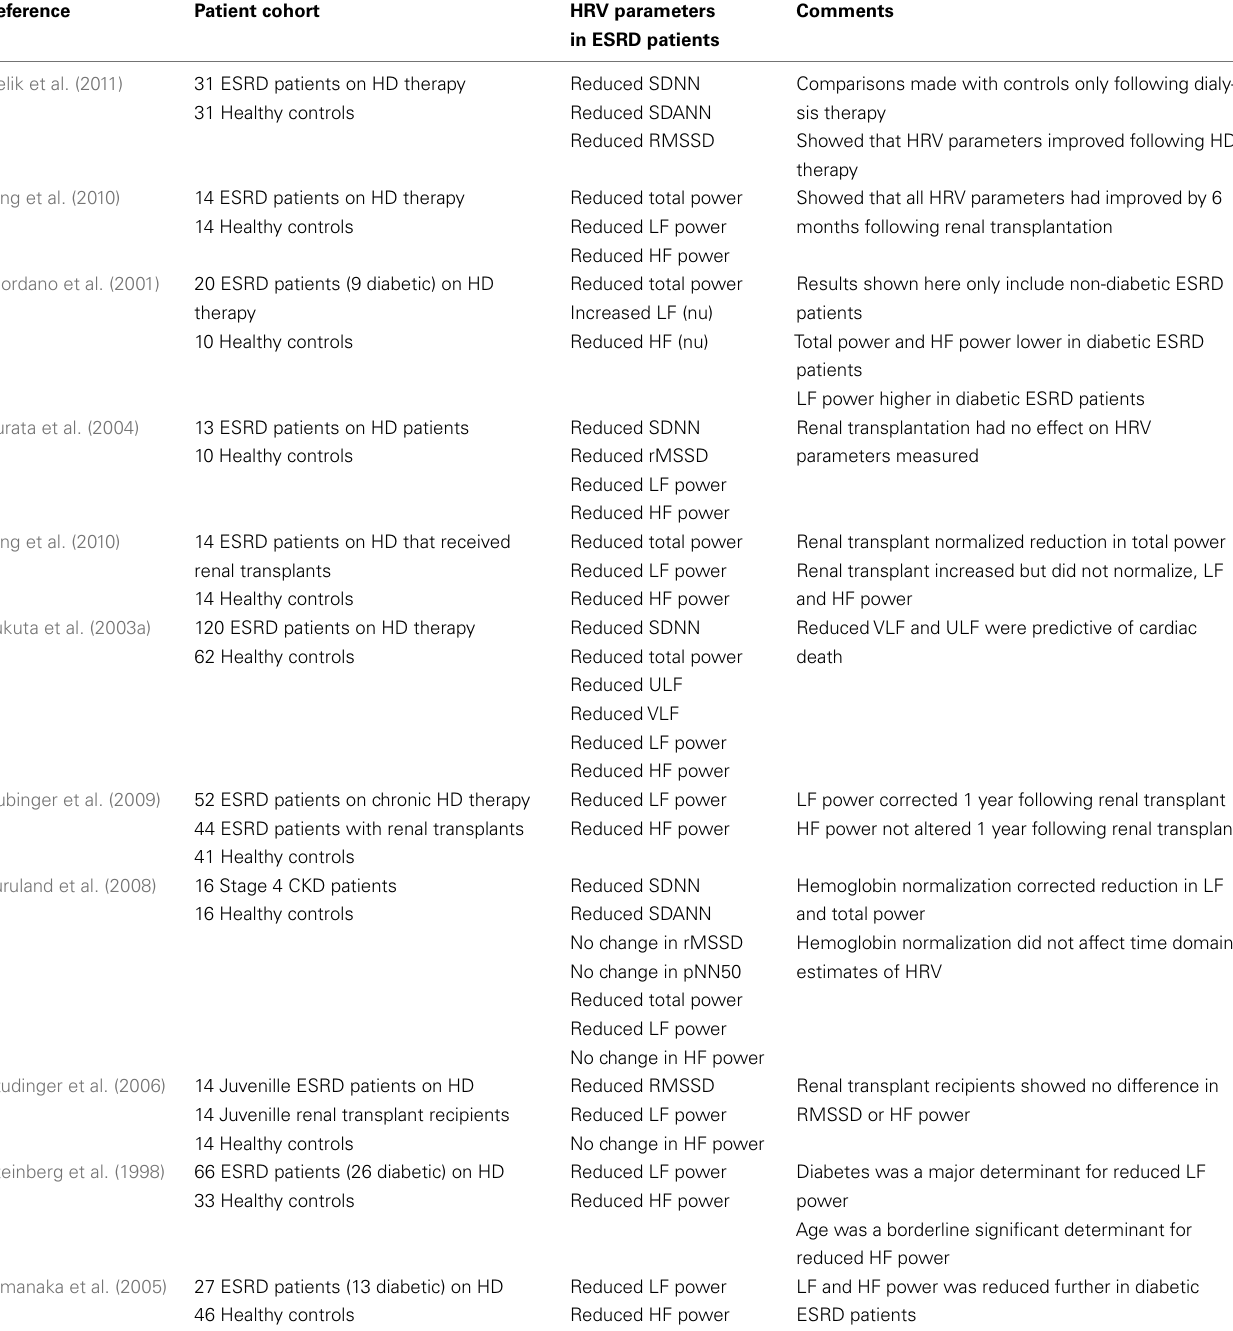
Table 1 | Heart rate variability parameters in end-stage renal disease